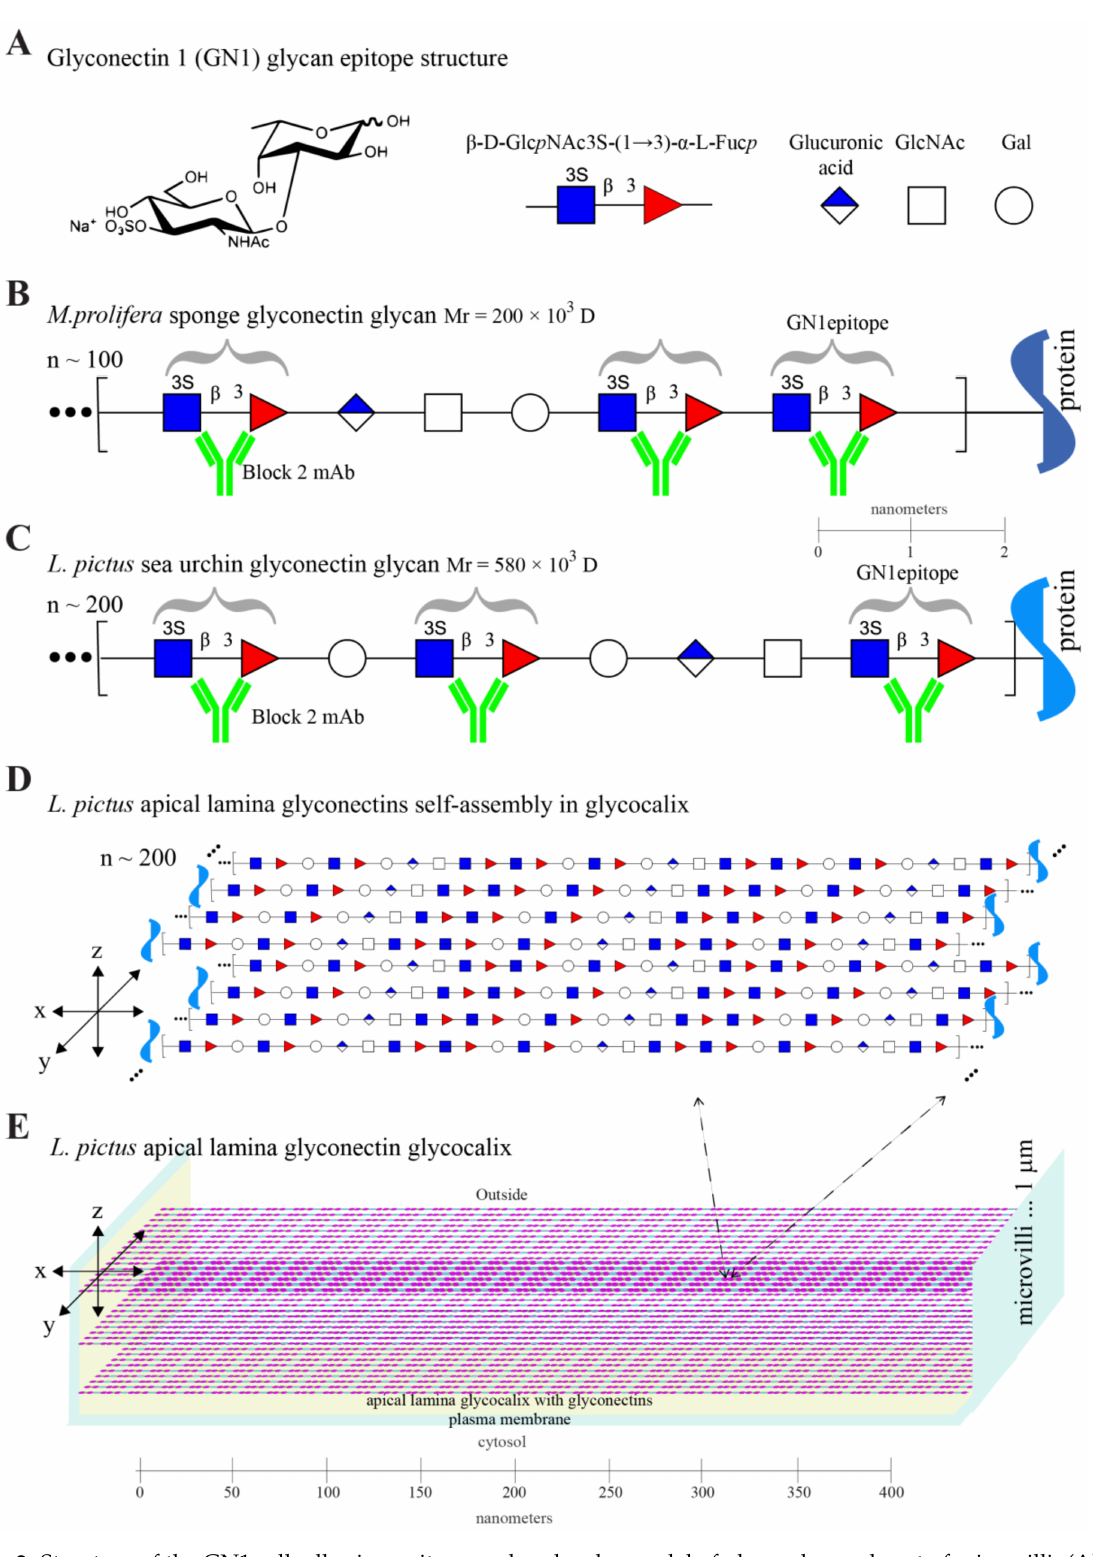
Figure 2. Structure of the GN1 cell adhesion epitope and molecular model of glycocalyx and part of microvilli. ( A ) Gly- conectin 1 (GN1) glycan epitope structure. ( B ) M. prolifera sponge glyconectin glycan. ( C ) L. pictus sea urchin glyconectin glycan. ( D ) L. pictus apical lamina glyconectins self-assembly in glycocalyx. ( E ) L. pictus apical lamina glyconectin glycocalyx. Using a semiquantitative approach based on the number of the anti-GN1 Block 2